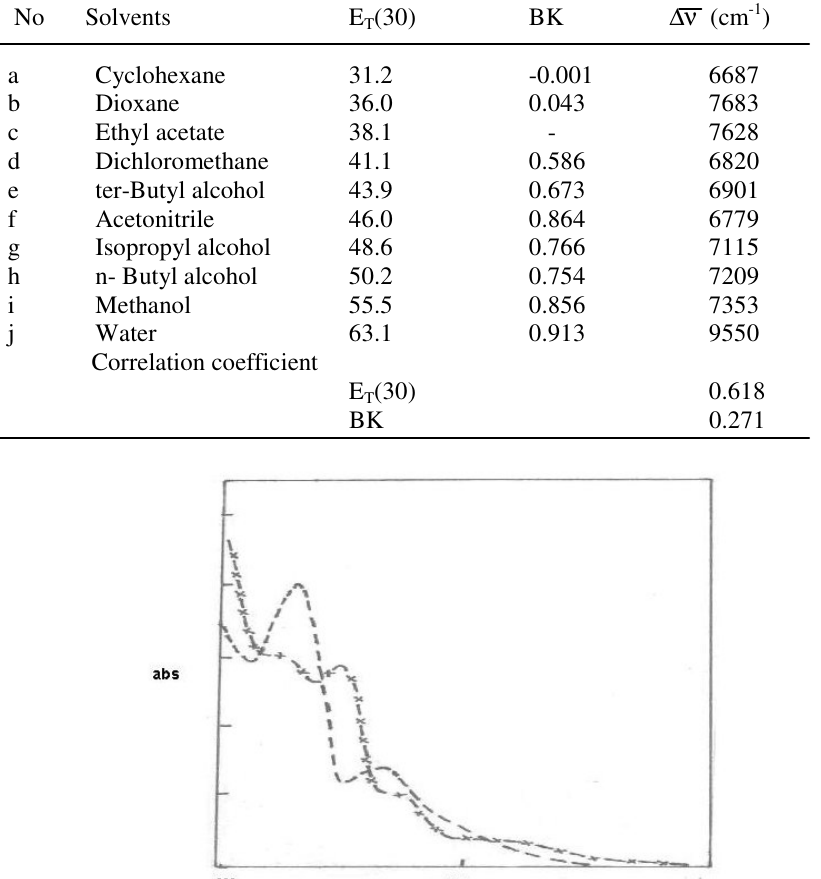
Table 2 . Stokes shifts observed for DAAQ in different solvents with E T (30) and BK values.